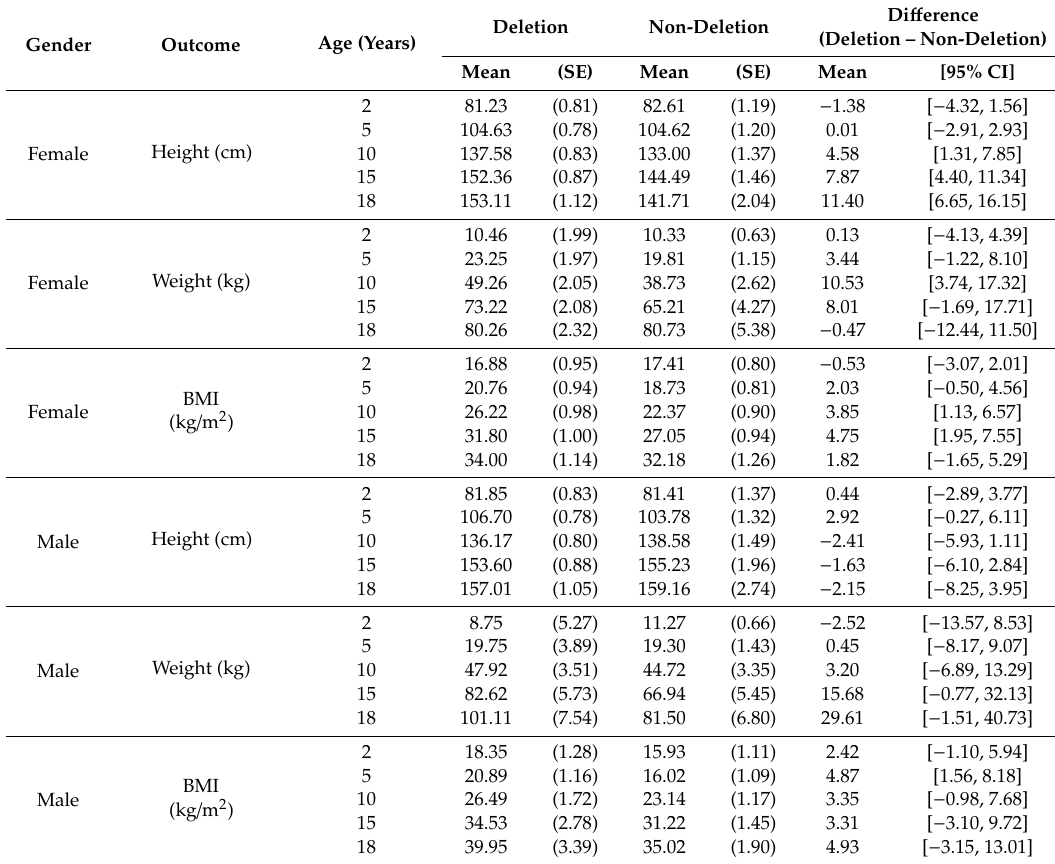
Table 2. Estimates of mean outcome measure by age for individuals with the deletion or non-deletion mechanism of Prader–Willi syndrome (PWS) in the observed data (without adjustment), estimated using linear mixed models with cubic